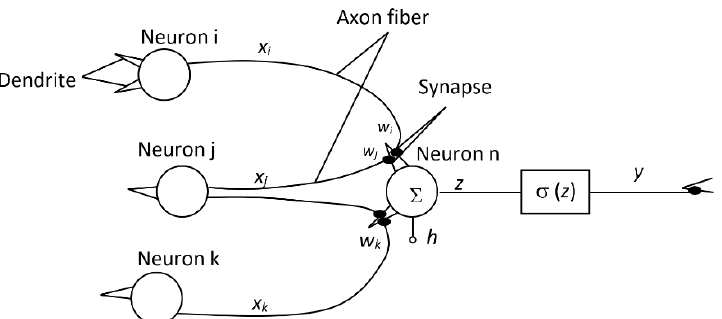
Figure 2. Schema of an artificial neuron inspired by a biological model and how it connects to other neurons.